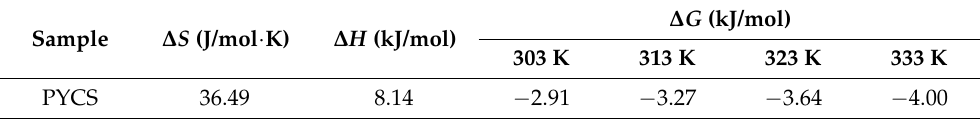
Table 4. Thermodynamic parameters for Fe (III) adsorption on PYCS.